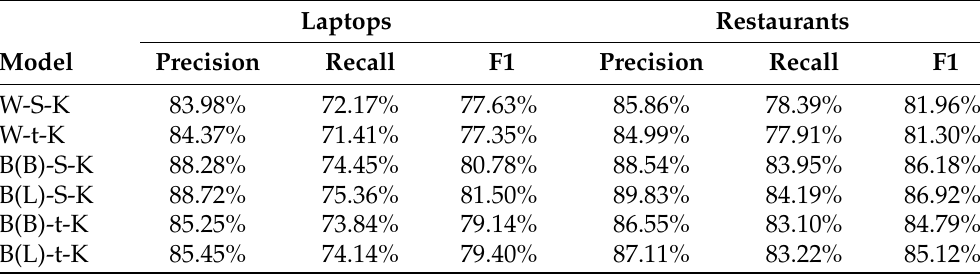
Table 2. The results of applying different aspect term extraction models on the SemEval-14 datasets, using the K value equal to 150 with the Laptops dataset and 200 with the restaurants’ dataset.